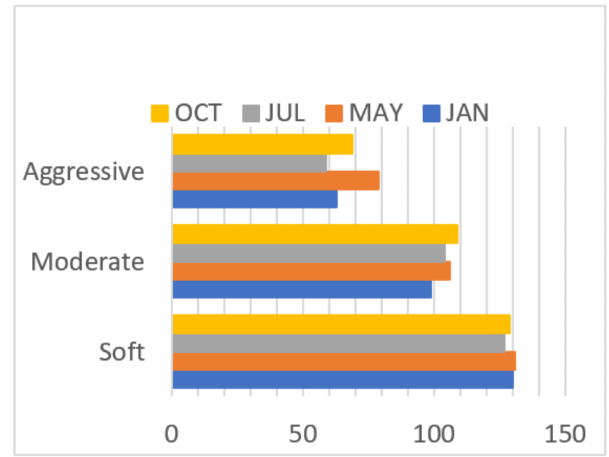
Figure 9. Number of Selsumers per